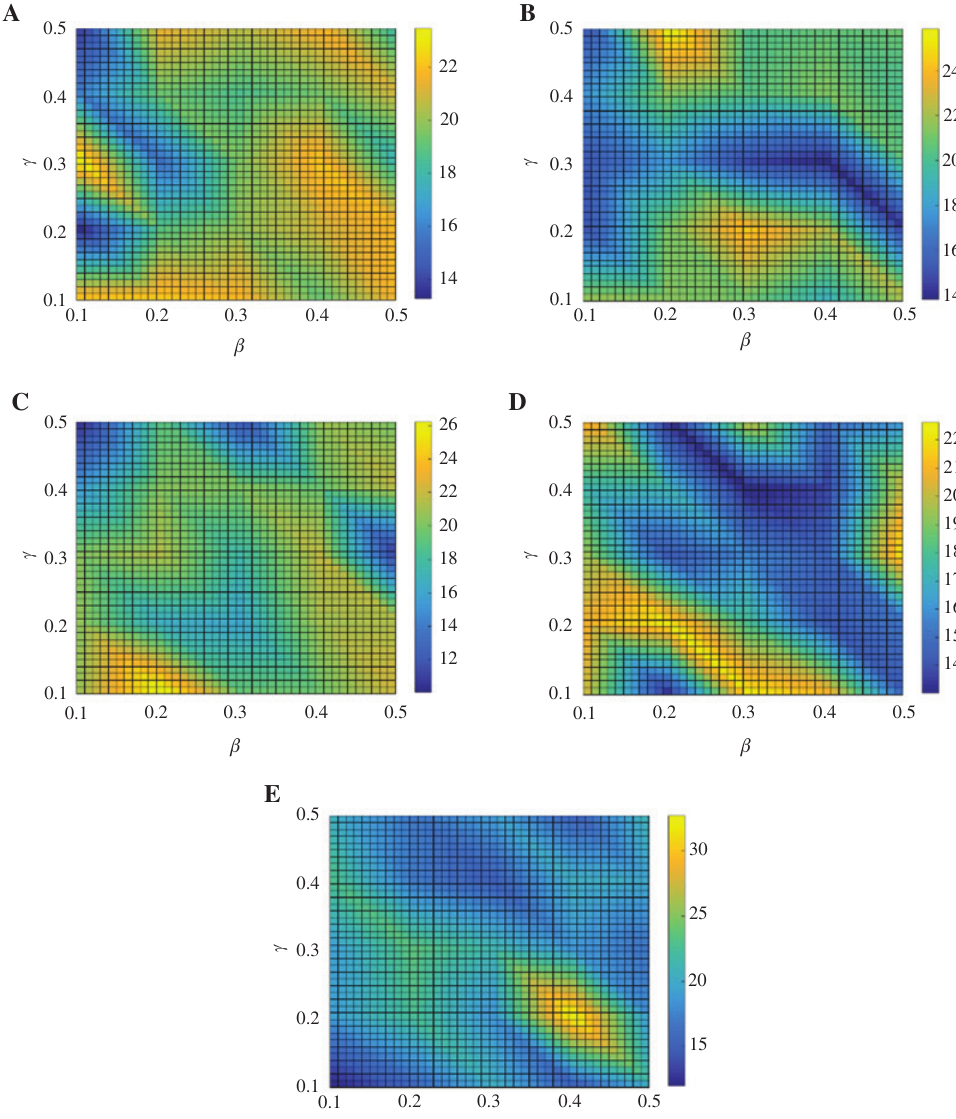
Figure 9: Estimation of electrical power under varying β and γ with the reference of α as (A) 0.1, (B) 0.2, (C) 0.3, (D) 0.4, and (E)